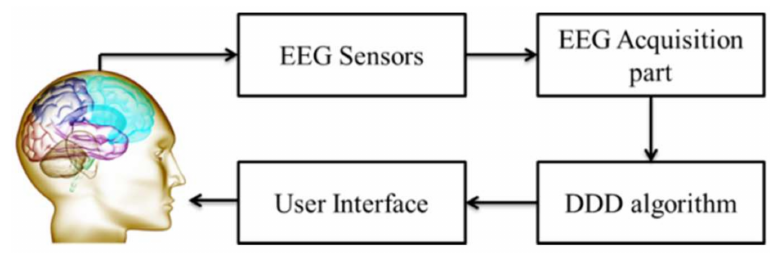
Figure 1. Block diagram of a typical EEG-based DDD